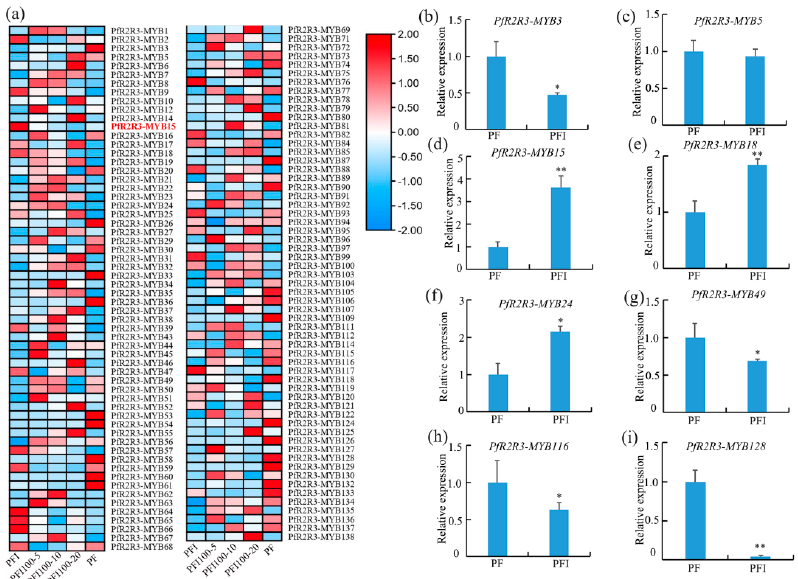
Figure 5. Expression pattern analysis of PfR2R3-MYB genes. ( a ) PfR2R3-MYB gene expression in phytoplasma-infected P. fortunei seedlings (PFI), PFI treated with 100 mg·L − 1 Rif for 5, 10, and 20 days (PFI100-5, PFI100-10, and PFI100-20) and PF ( P. fortunei seedlings). ( b – i ) QRT-PCR analysis of eight DEGs in PF and PFI. The error bars indicate the standard errors of three biological replicates. Asterisks indicate a significant difference (**, p < 0.01; *, p < 0.05) between PF and PFI.